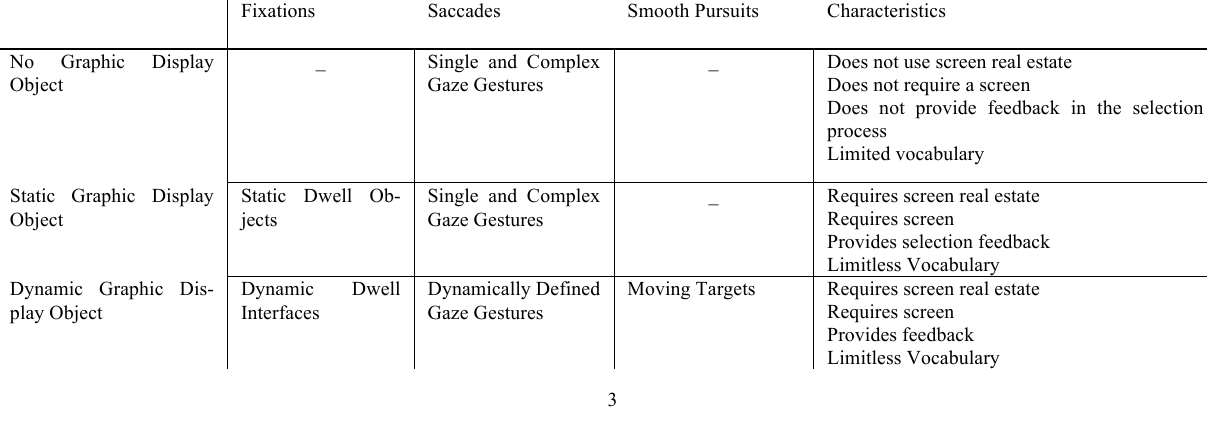
Overview of the interaction between eye movements and graphic display